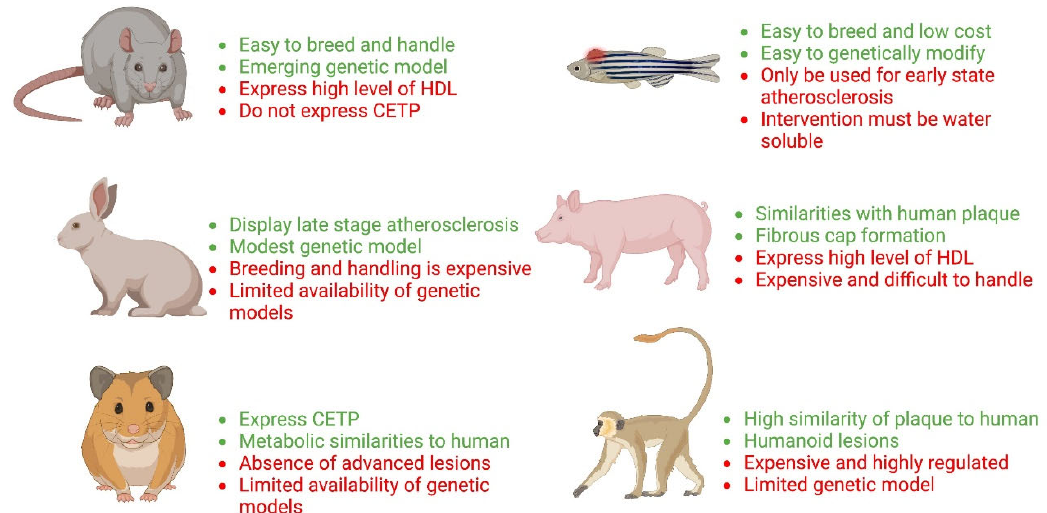
Figure 1. Main characteristics of non-mouse animal models of atherosclerosis. Green colour indicates advantages while red colour indicates disadvantages of these animal models.